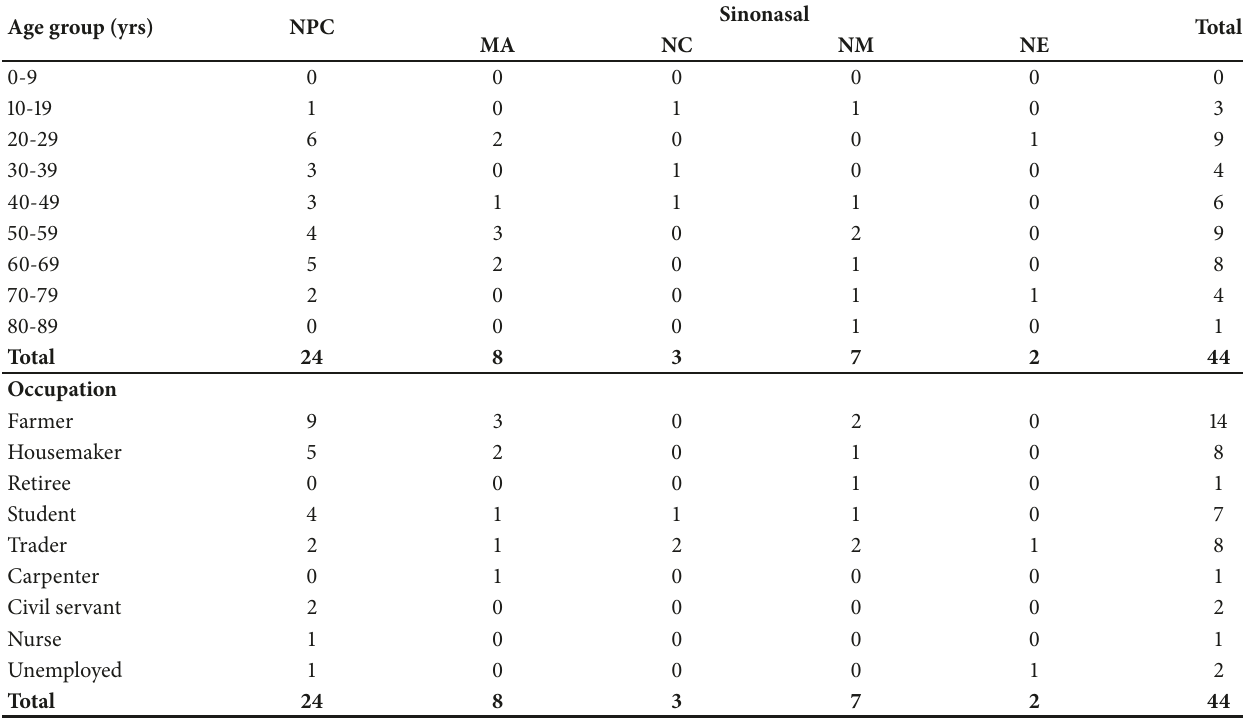
Table 1: Sociodemographic characteristics of study population (n=44) by tumor sites.